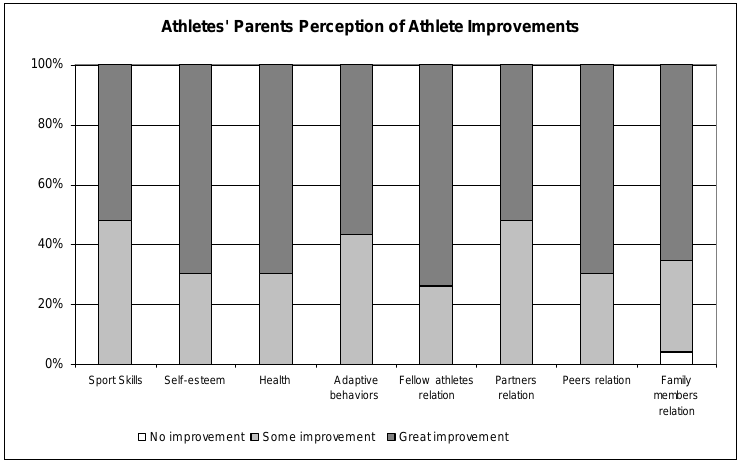
Figure 1 . Perception of athletes’ parents on athlete improvement at the end of the program Athletes' Parents Perception of Athlete Improvements